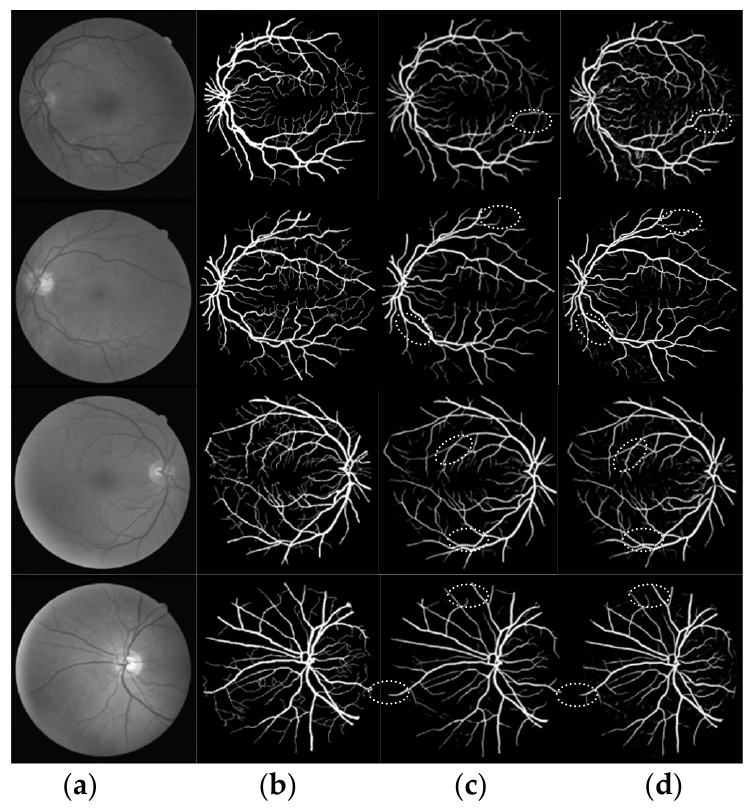
Figure 10. Comparison of segmentation results ( a ) original image ( b ) gold standard image ( c ) liter- ature [22]. 2019 Pan, X. ( d ) algorithm of this paper.